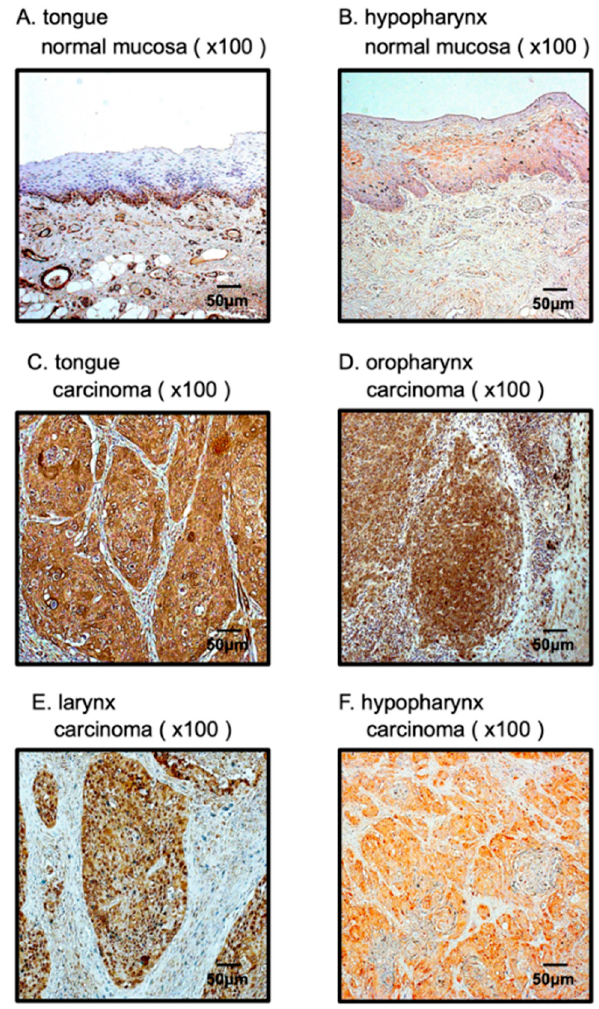
Figure 7. Overexpression of PFN2 in HNSCC clinical specimens. ( A , B ) Weak expression was detected in the normal mucosa. ( C – F ) High expression of PFN2 was detected in the nuclei and/or cytoplasm of HNSCC cancer cells.